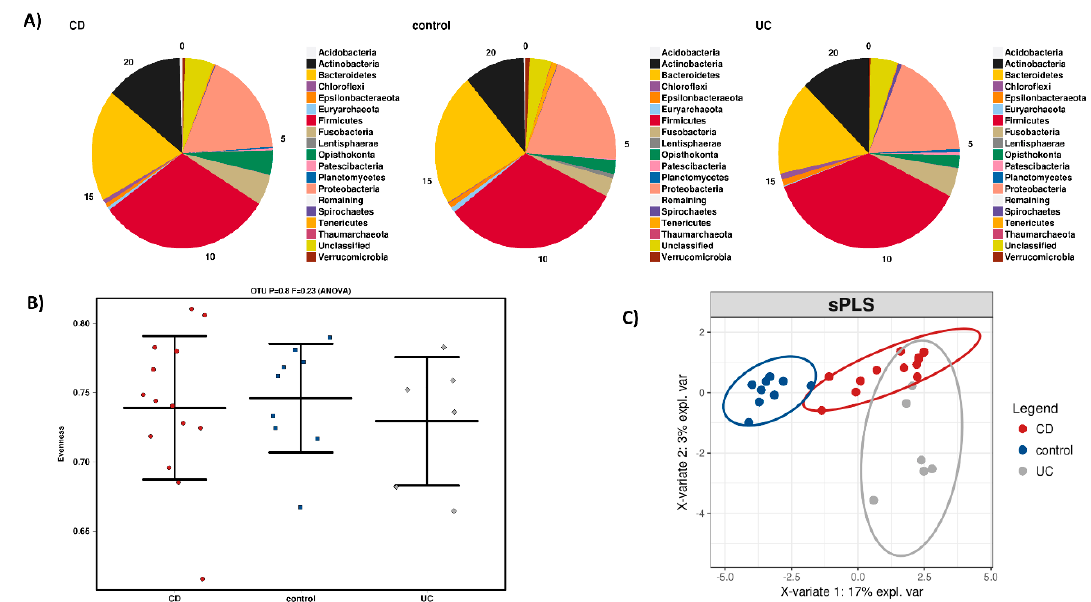
Figure 2. ( A ) Microbiota composition changes at phylum level among healthy controls, Crohn’s disease and ulcerative colitis patients. ( B ) α -diversity (quantification of biodiversity) di ff erences in the 3 groups. ( C ) β -diversity (qualitative enterotype di ff erences) of the 3 groups.